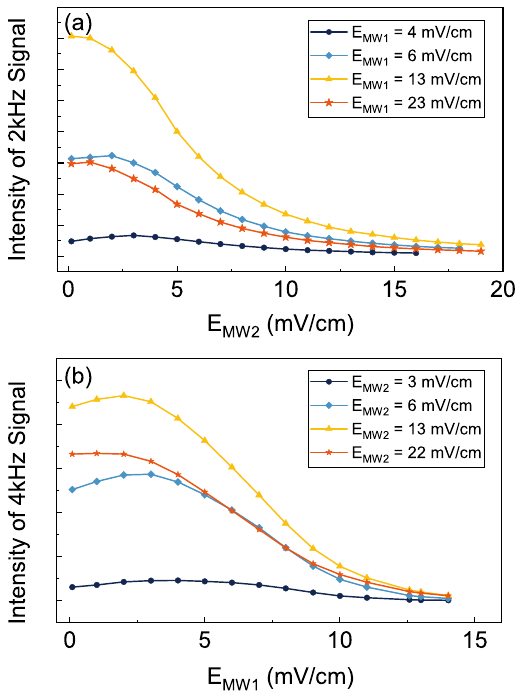
Figure 2. The recorded photoelectric signal intensity of baseband signals by our Rydberg atom-based receiver for different E-intensities of MW1 and MW2. In either case, ( a ) or ( b ), the intensity of the baseband signal with ω 1 = 2 × 2 π kHz ( ω 2 = 4 × 2 π kHz) modulated onto MW1 (MW2) gradually decay with the intrusion of the opponent MW power beyond E MW ∼ 2.5 mV/cm. However, in both cases, the signal intensity climbs up along its own channel microwave intensity until reaching the maximum at E MW ∼ 13 mV/cm, and then drops again, implying an available power